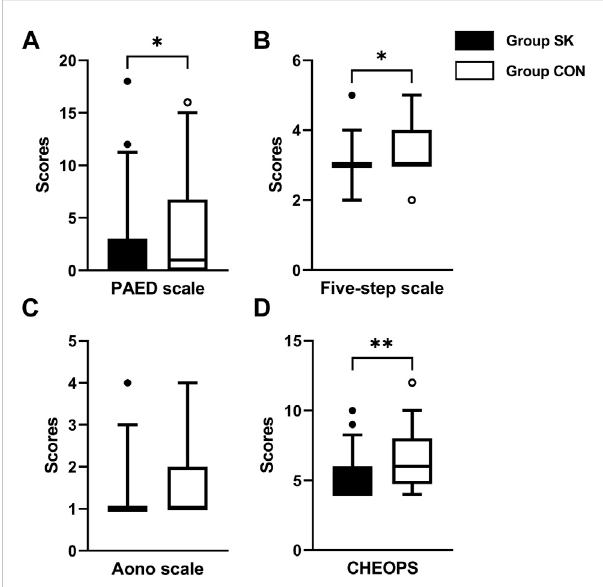
FIGURE 2 Postoperative assessment scores of PAED scale (A) , Aono scale (B) , fi ve-step ED scale (C) and CHEOPS (D) . Data are expressed as median (horizontal bar), interquartile range (box), 5-95 percentile (whiskers) and outliers (circles). Inter-group differences were comparedusingMann-Whitney U test.* p < 0.05whencomparedwith the control group. ** p < 0.01 when compared with the control group. Group SK, the S-ketamine group; Group CON, the control group; PAED, pediatric anesthesia emergence delirium; CHEOPS, Children ’ s Hospital of Eastern Ontario pain score of ≥ 3) were subjected to the analyses: intervention (injection with S-ketamine or not), age, gender, BMI, PSAS score, induction cooperation degree, duration of anesthesia, time to extubation, and